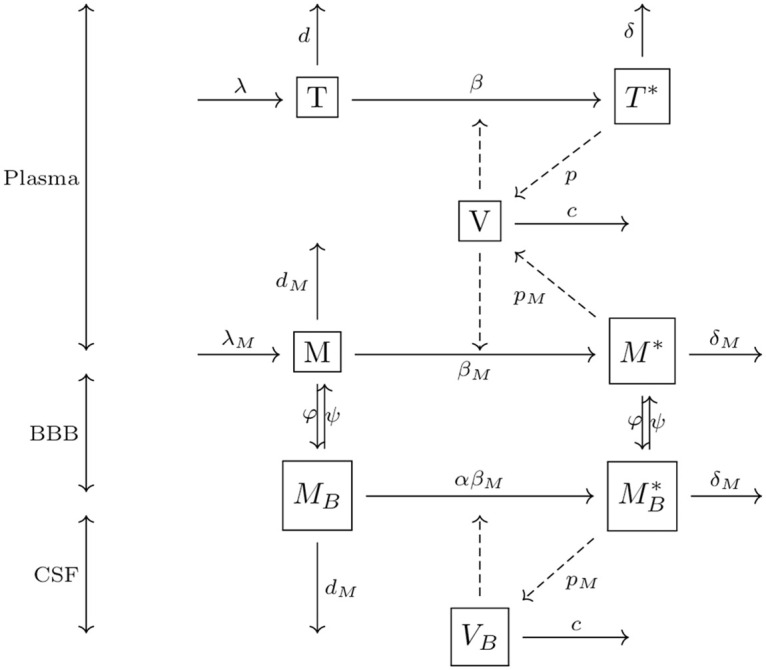
The schematic diagram of the model representing HIV-1 infection in the brain.The boxes represent a cell population, the solid arrows represent transport from one population to another, and the dashed arrows represent the cause for the corresponding events.